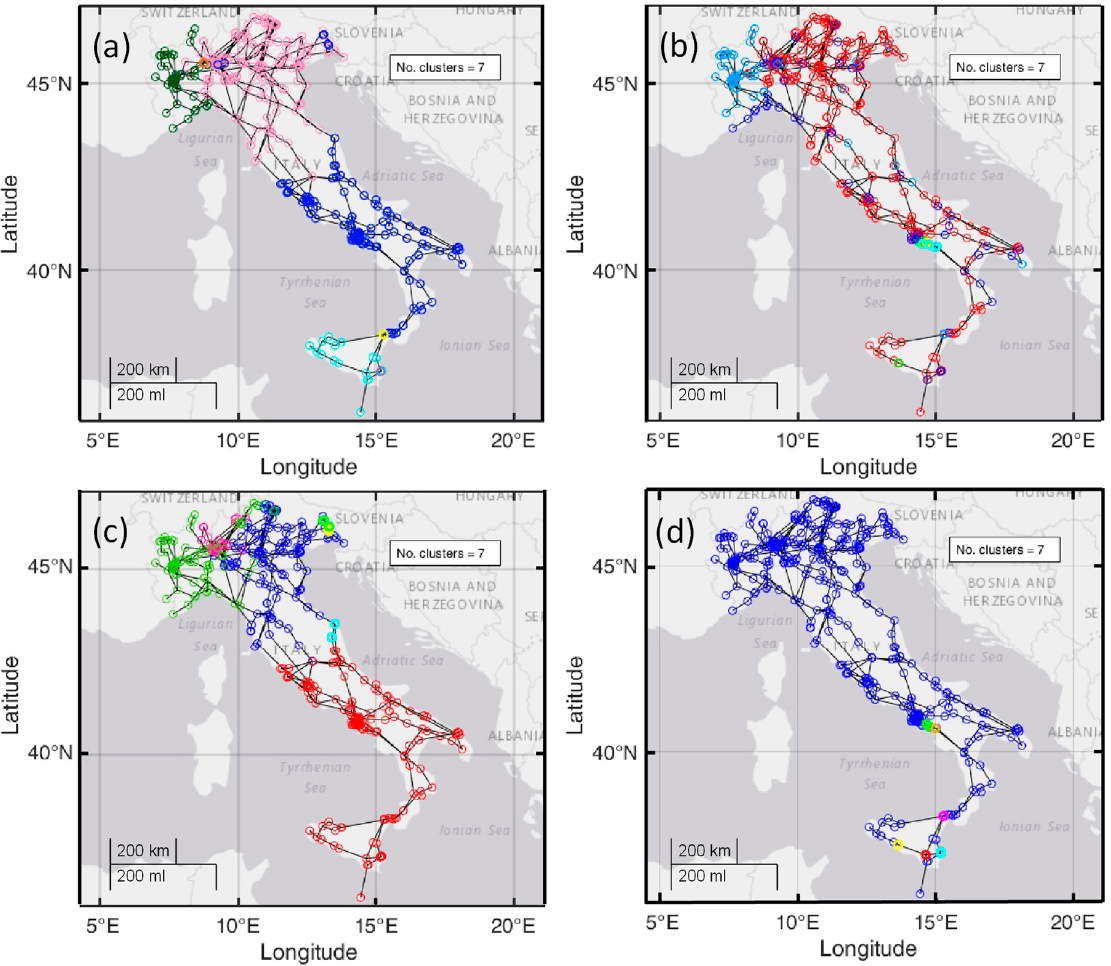
Figure 8. Solution with seven clusters obtained through: ( a ) k-means, LMP s; ( b ) k-means, PTDF s; ( c ) spectral clustering, LMP s; ( d ) spectral clustering, PTDF s. The scenarios are not weighted.